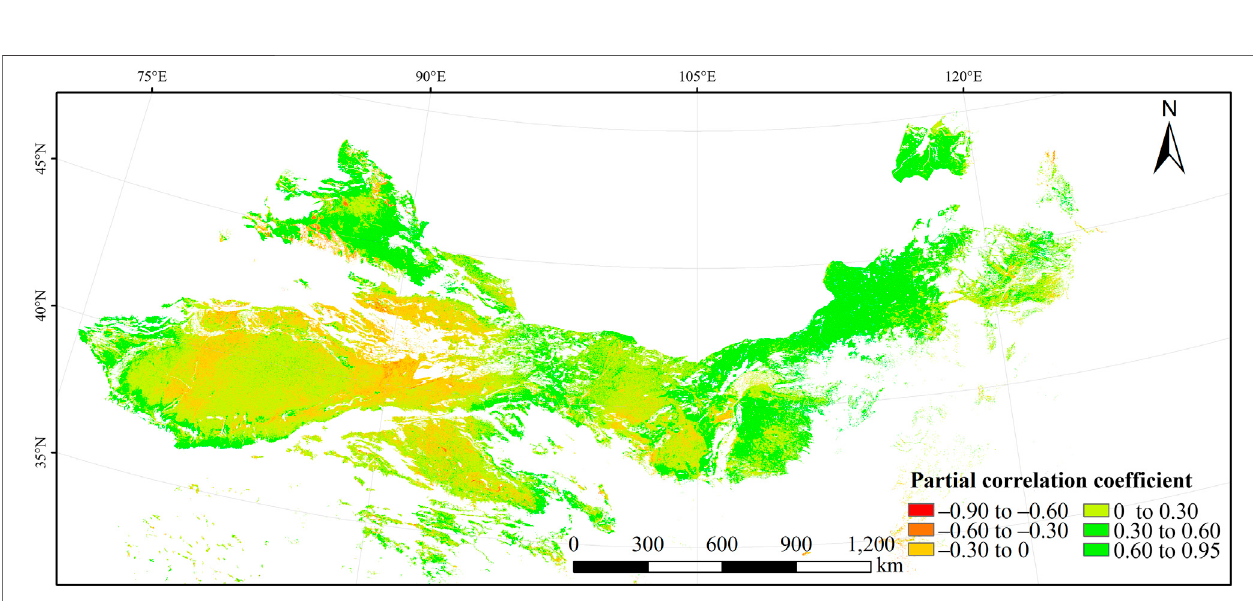
Frontiers in Environmental Science |